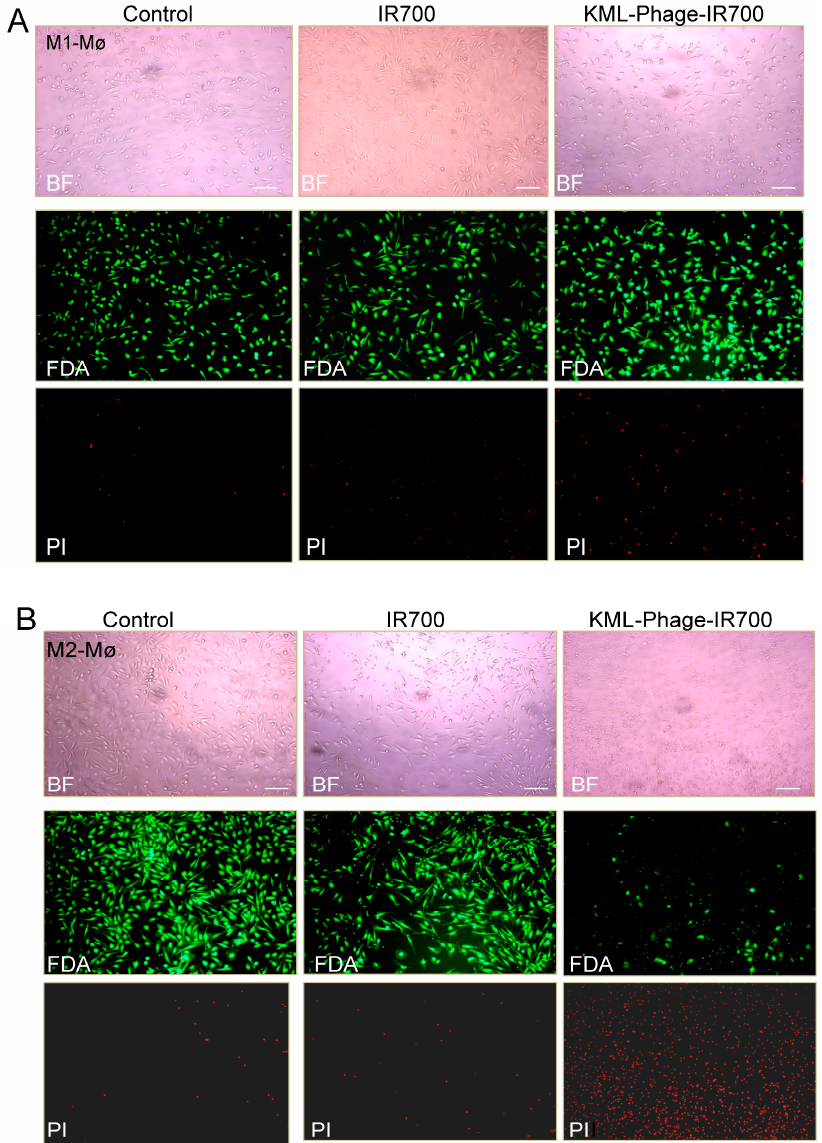
Figure 8. Photocytotoxicity of the KML Phage-IR700 conjugate. M1 ( A ) and M2 ( B ) macrophages were incubated with either IR700 dye (50 nM) or the KML-phage-IR700 conjugate for 1 h at room temperature, washed, and then exposed to NIR light 35 J/cm 2 at power density of 17 mW/cm 2 . Thereafter-, the cells were incubated at 37 °C for 3 h and then Light fluorescence microscopy images of cells counter-stained with fluorescein diacetate (FDA) and propidium iodide (PI) were taken. Scale bars present 100 μ m. BF, bright field.